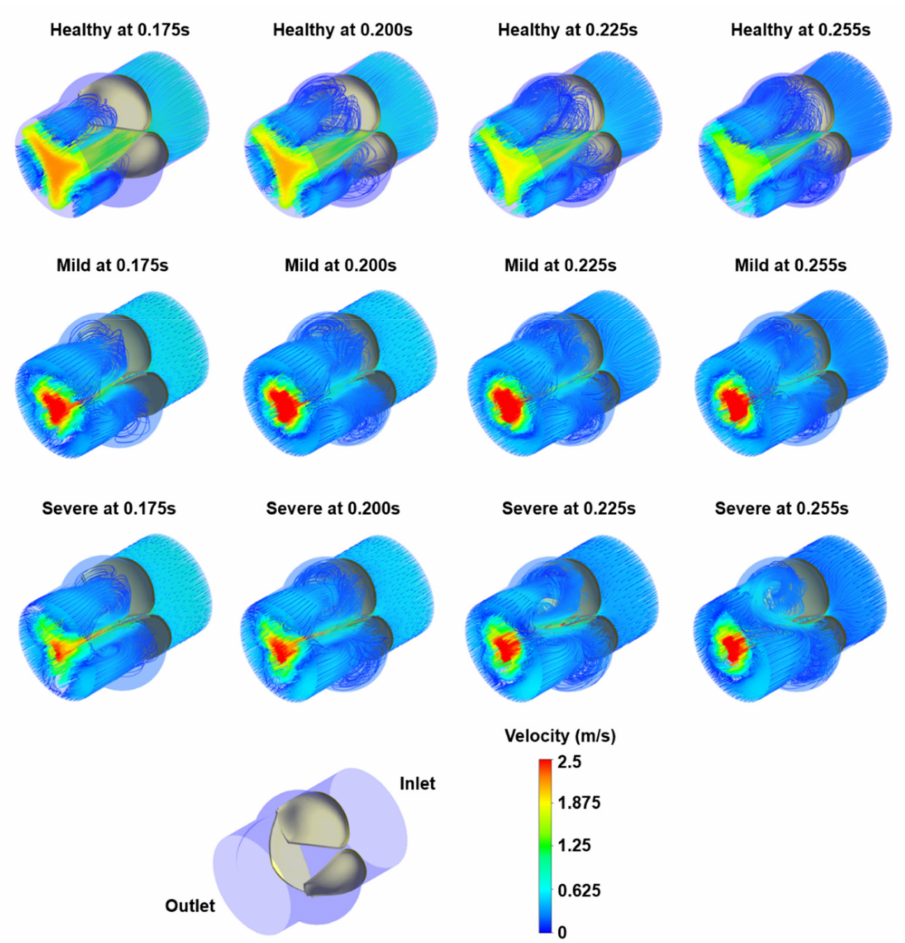
Figure 2. Velocity streamlines on the 3D aortic valve model. The configuration of the maximum valve opening for the healthy aortic valve is given at the bottom of the